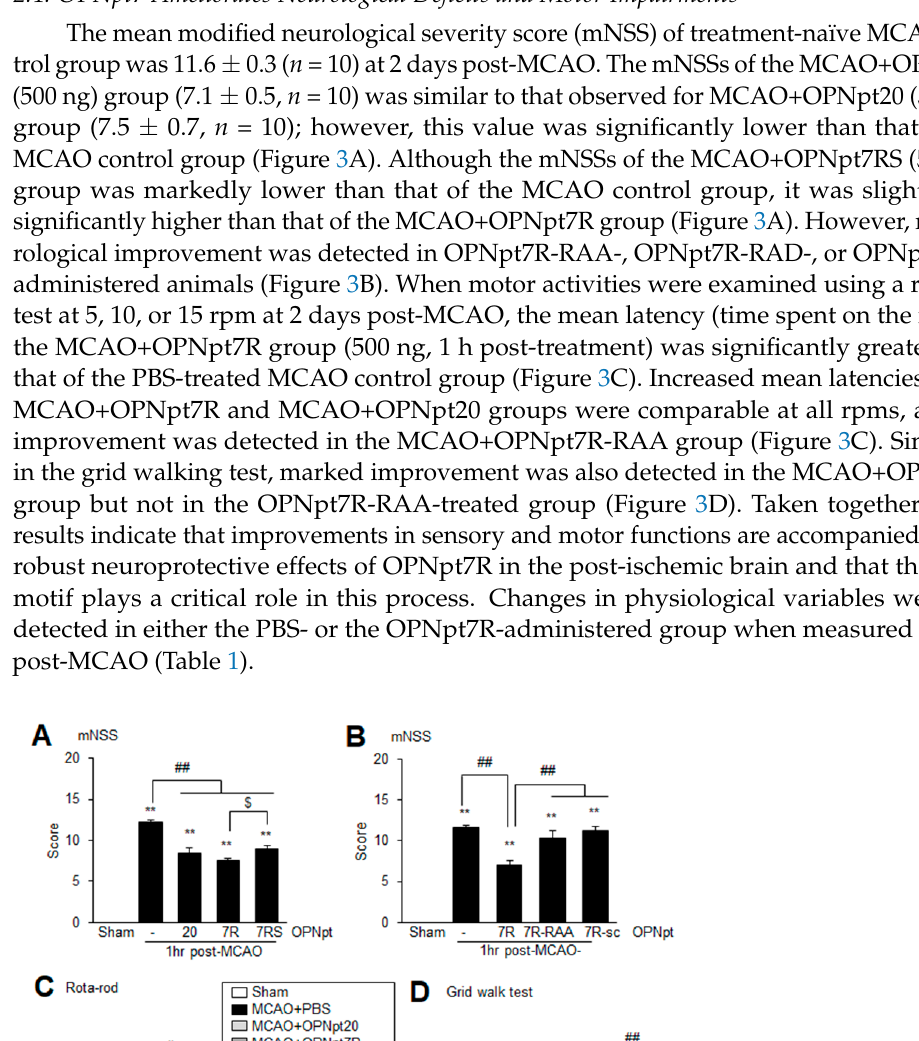
Table 1. Physiological parameters.